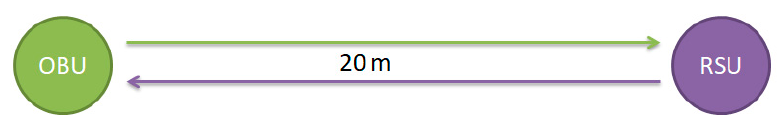
Figure 6. Design of preliminary tests in Boecillo.